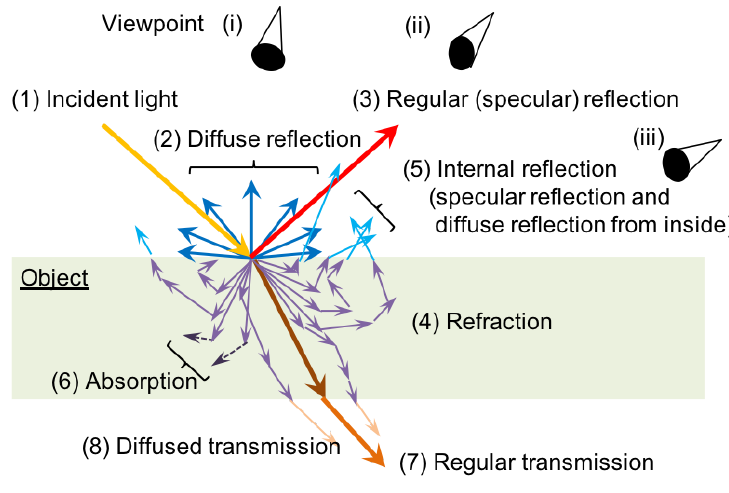
Figure 4. Basics of